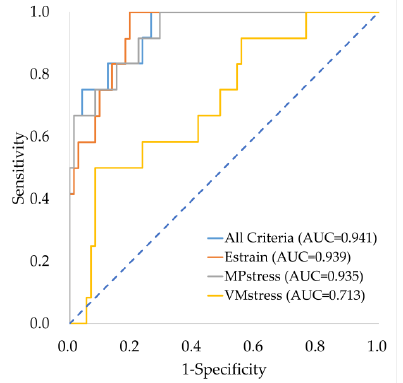
Figure 16. Four ROC curves of logistic regression of principal components from different biome- chanical criteria to predict the injury manners (impact and run-over).